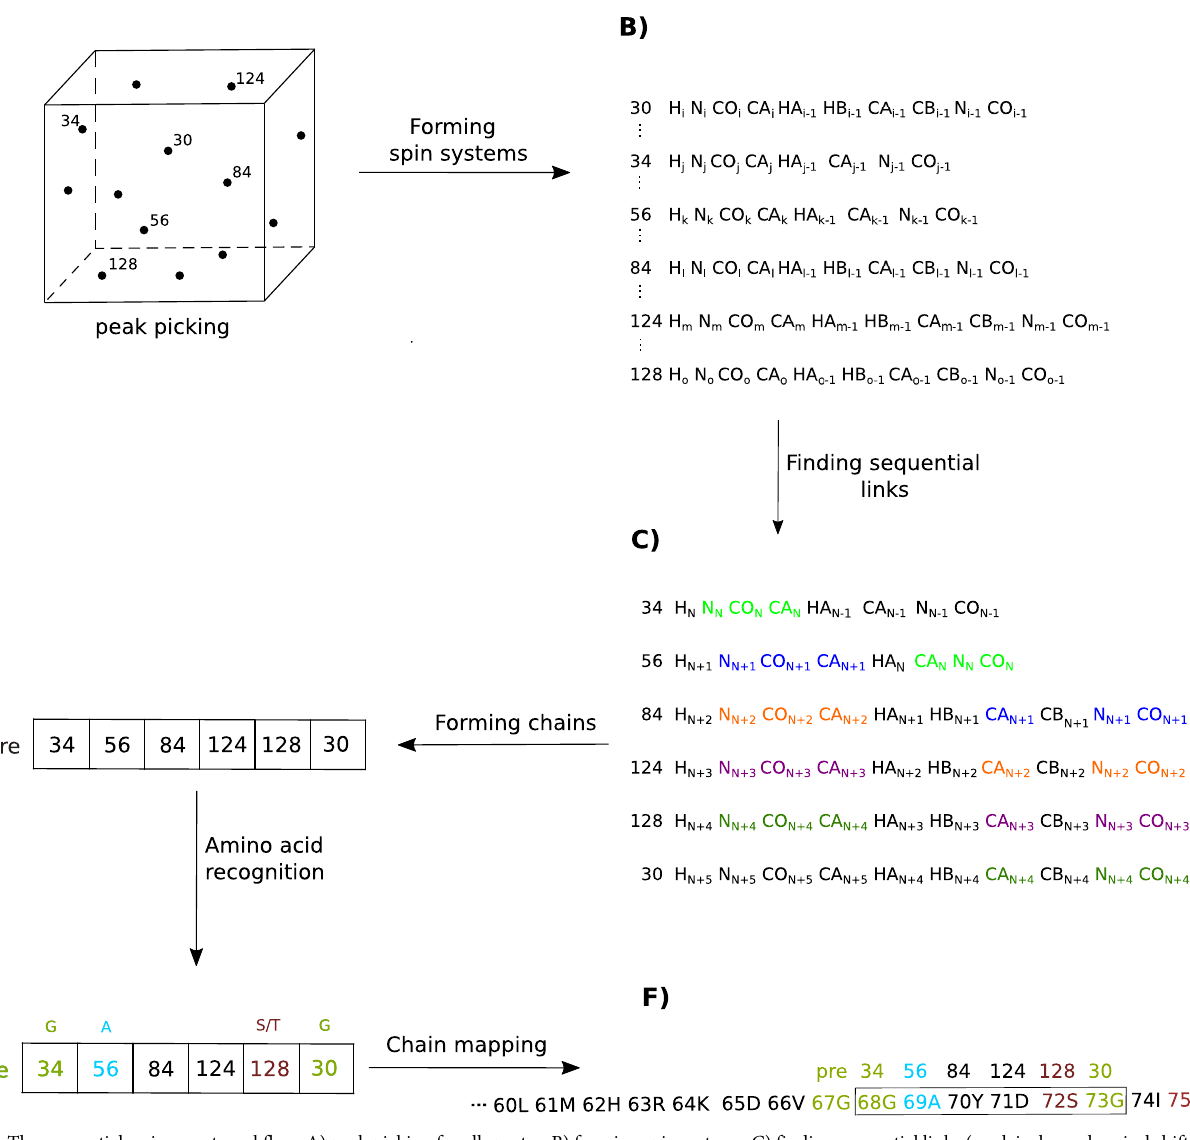
Fig 1. The sequential assignment workflow: A) peak picking for all spectra; B) forming spin systems; C) finding sequential links (nuclei whose chemical shifts are used to find the connections between adjacent amino acid residues are marked with different colors); D) forming chains (the numbers of consecutive spin systems are given in boxes; the label “pre” denotes the residue preceding the formed chain for which some chemical shifts are known; E) amino acid recognition based on characteristic chemical shifts; F) chain mapping onto the protein